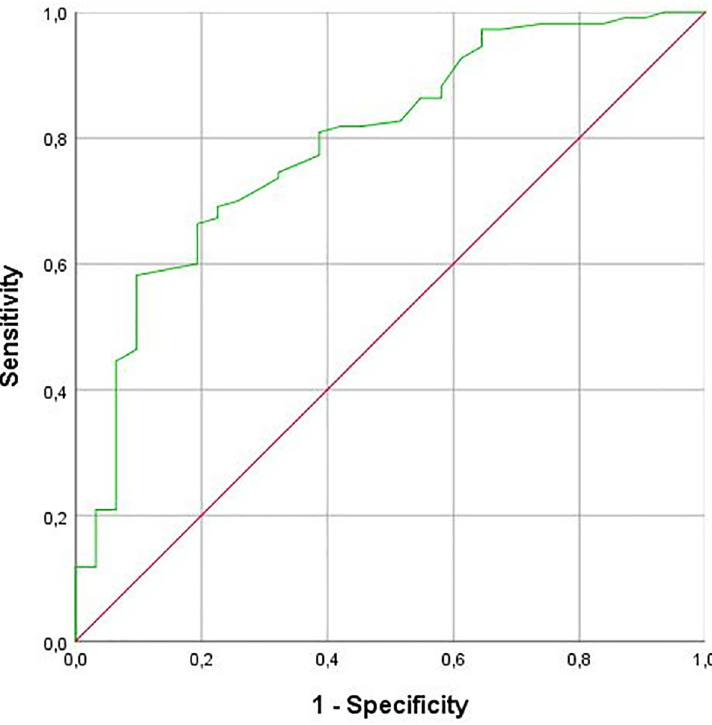
Fig 4. ROC-curve assessing an optimal threshold of SUV peak for high diagnostic certainty of 18 F-DCFPyL PET- detected lesions.